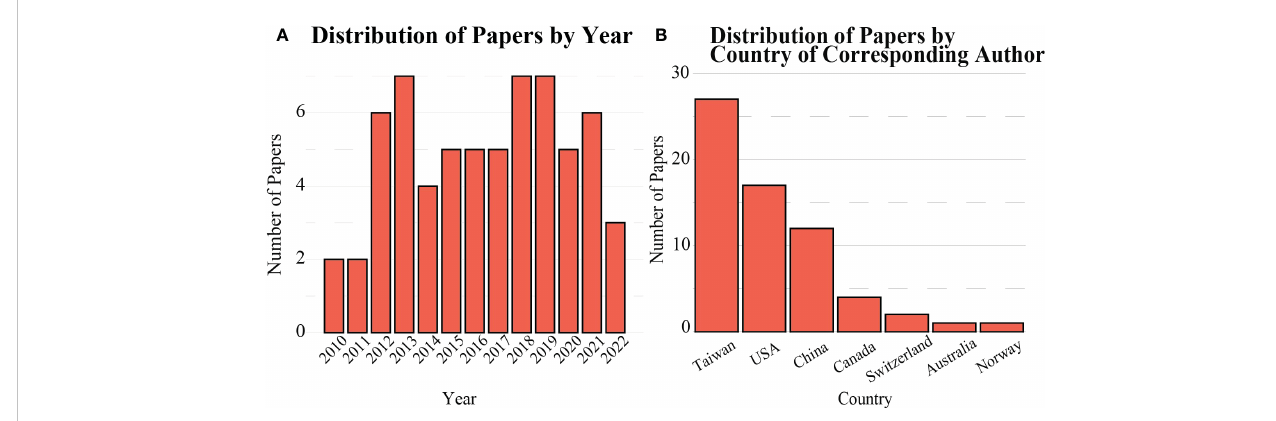
FIGURE 3 Distribution of scienti fi c literature published on FUS-mediated BBB opening for in vivo rodent models (A) over time, and (B) by